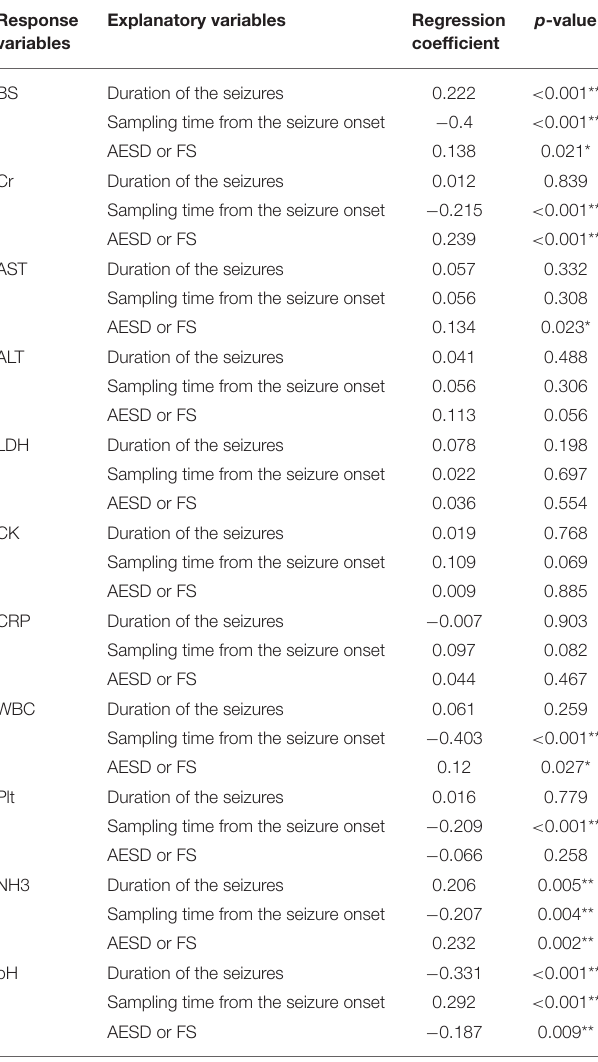
TABLE 2 | The values of laboratory data and the range of sampling time from seizure onset in AESD and FS patients.